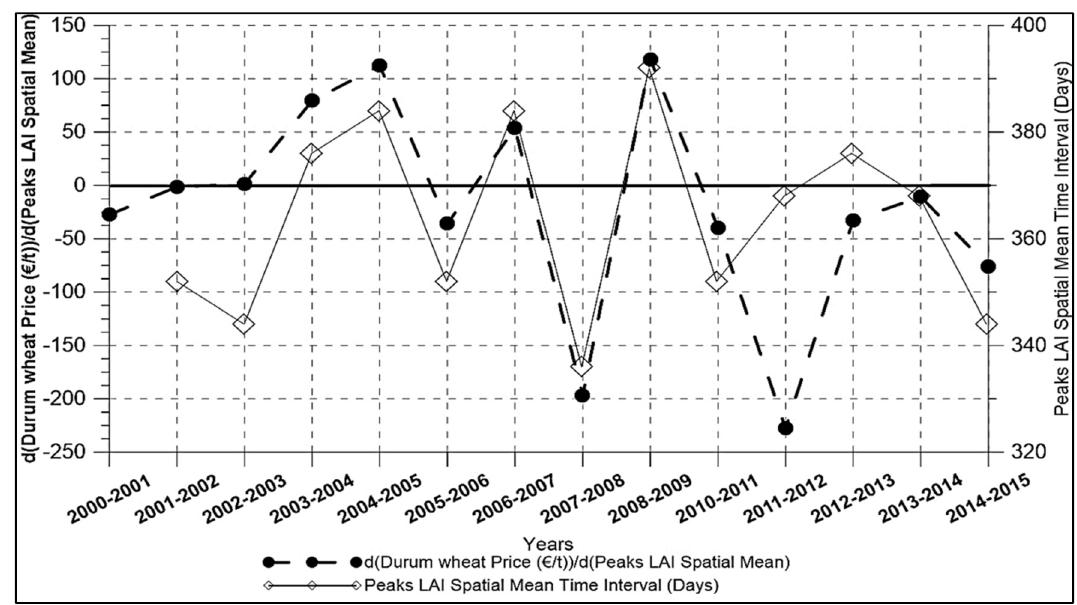
Figure 9. Peak LAI Spatial Mean response to price variation.